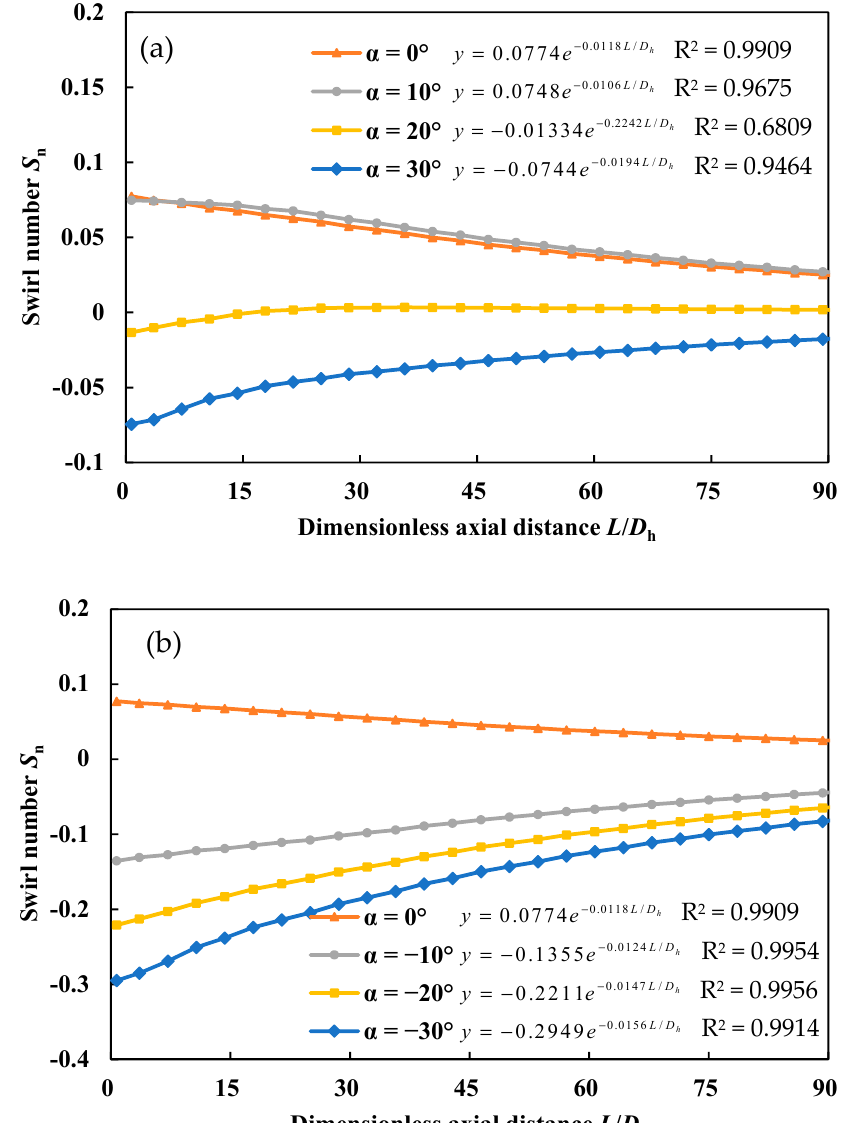
Figure 13. Variation curve of swirl number along the flow direction for the V-shaped blade with different helical angles at 120 rpm: ( a ) positive blade and ( b ) negative blade.